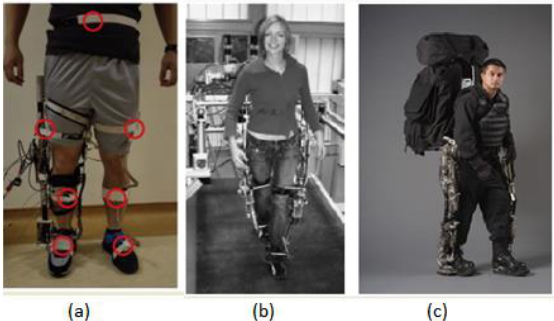
Figure 7. Multiple joints exoskeletons: ( a ) the National University of Singapore (NUS) exoskeleton [33]; ( b ) the lower extremity-powered exoskeleton (LOPES) (all lower limb joints) [35]; and ( c ) the Berkeley Lower Extremity Exoskeleton BLEEX [3].